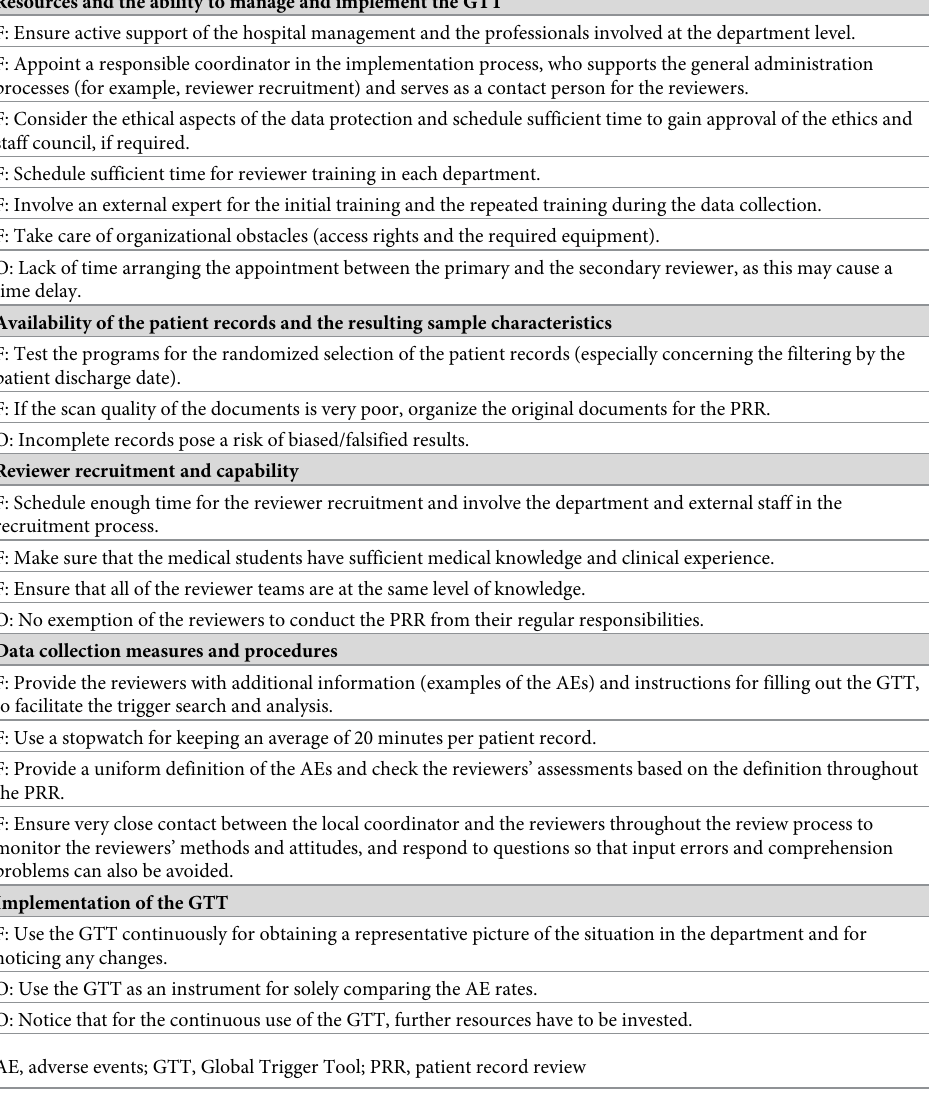
Table 4. Recommendations regarding the facilitators (F) and the obstacles (O) in the GTT-implementation process. Resources and the ability to manage and implement the